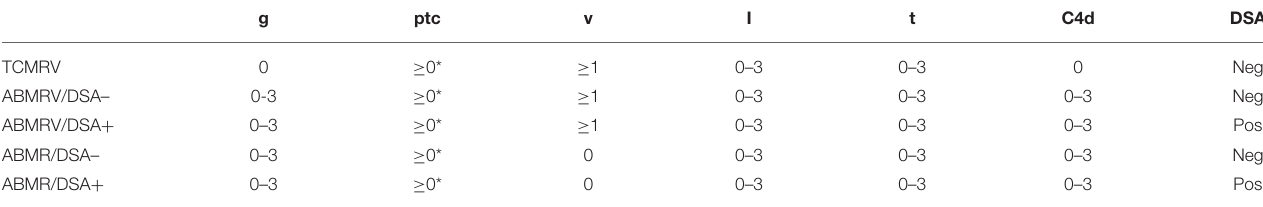
TABLE 1 | Definition of the rejection phenotype groups.